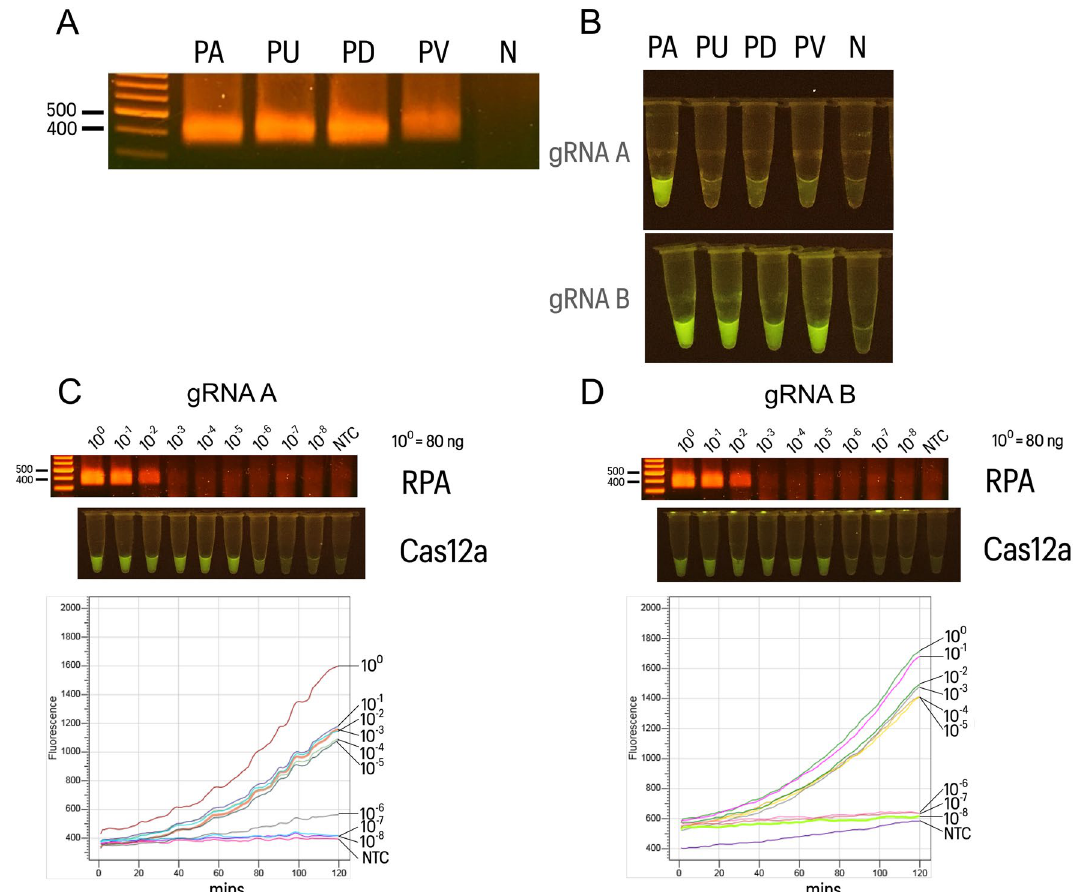
Figure 2. Specificity and sensitivity of Bar-cas12a for P. amarus authentication. ( A ) DNA amplification for the four species including P. amarus (PA), P. urinaria (PU), P. debilis (PD) and P. virgatus (PV) by RPA using universal trnL primer. ( B ) Specificity test by Bar-cas12a using gRNA-A and gRNA-B. ( C , D ) Sensitivity test by PCR and Bar-cas12a using gRNA-A and gRNA-B and the fluorescence signal were monitored for cleavage of ssDNA reporters by realtime PCR within two hours. Initial images of agarose gel electrophoresis are shown in Figure S2 and S3,